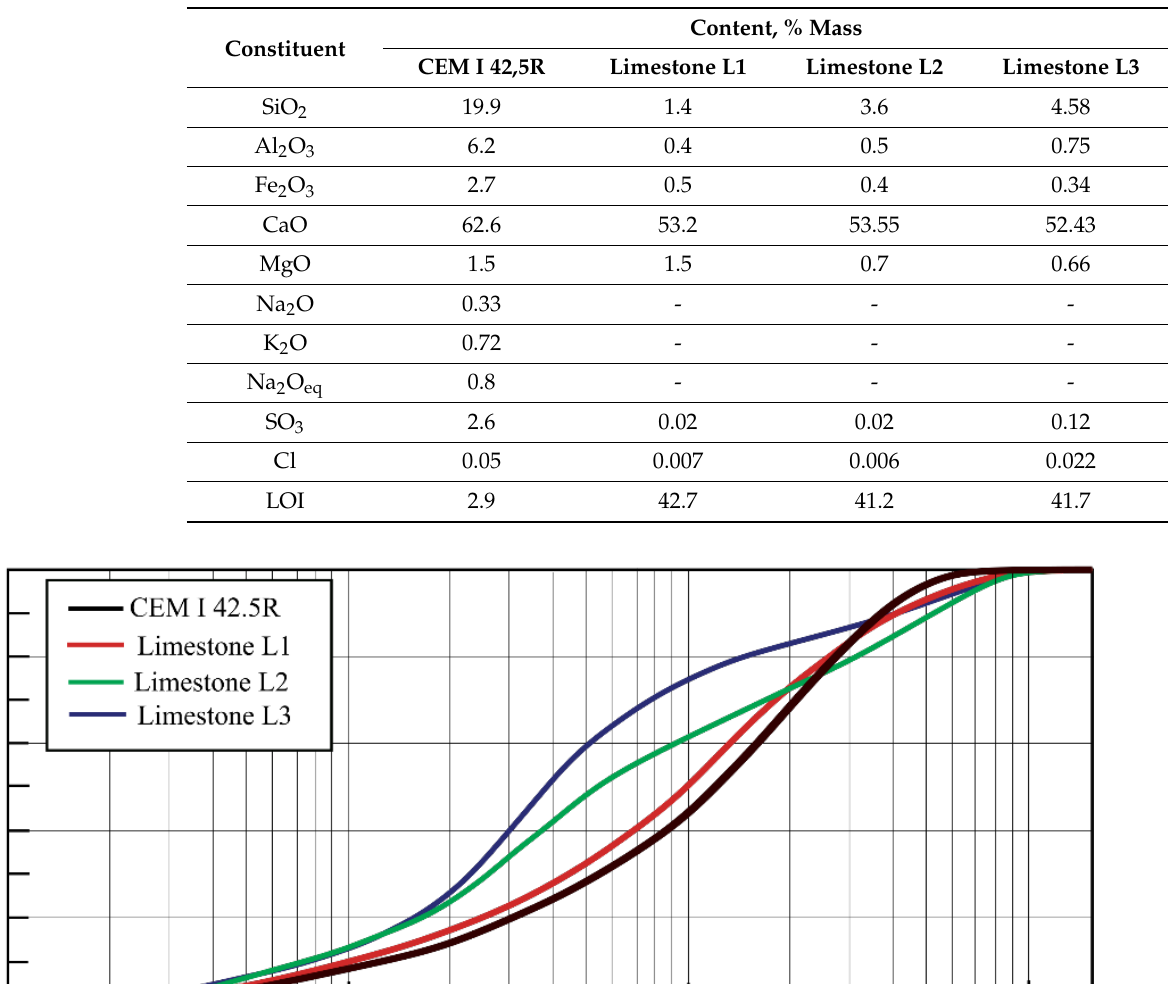
Table 1. Composition of materials used in the research.